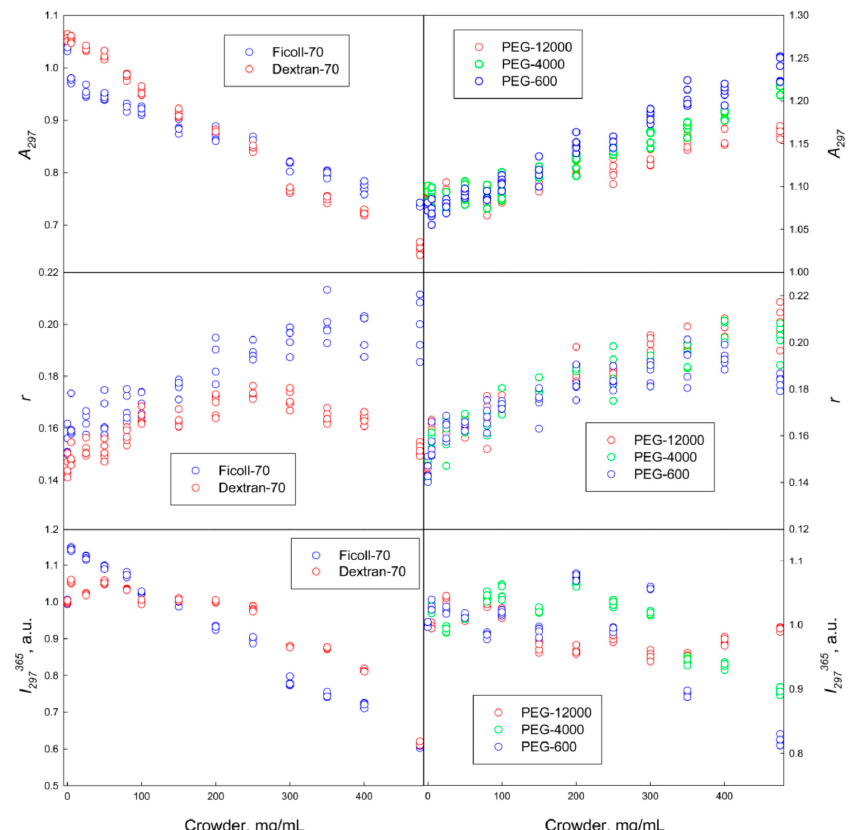
Figure 1. Characteristics of the GGBP intrinsic fluorescence in the presence of different crowding agents. The excitation wavelength was 297 nm.